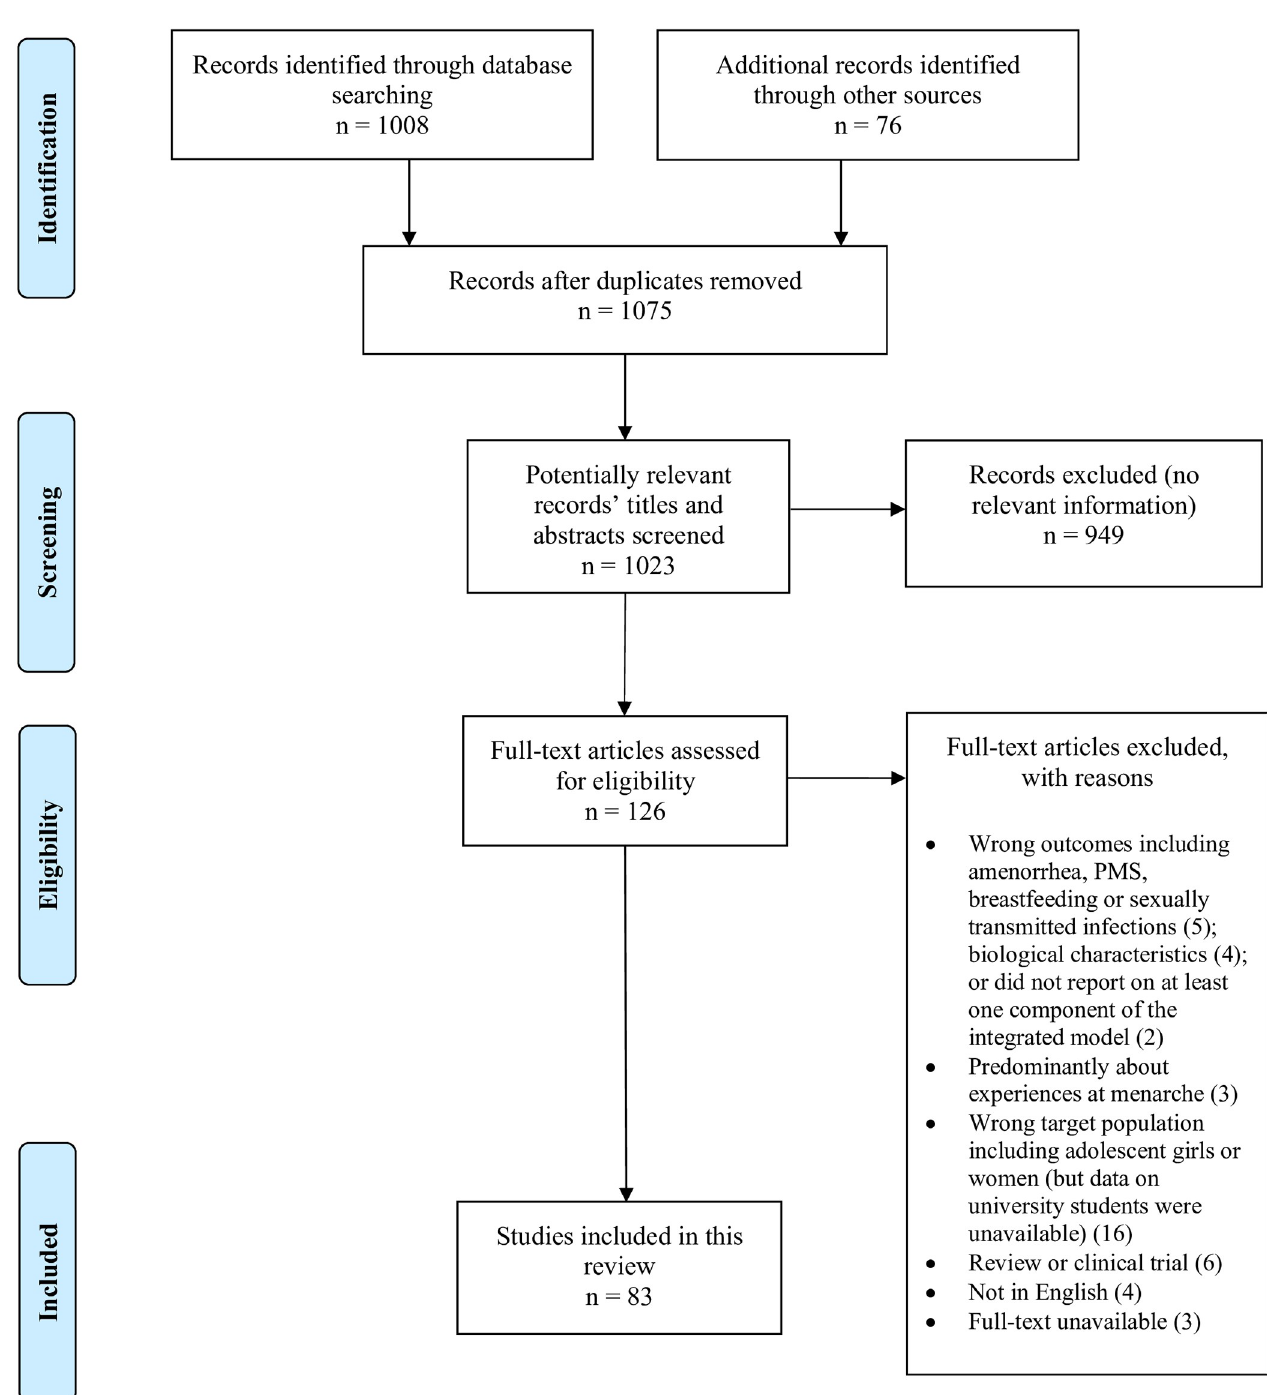
Fig 1. PRISMA flow diagram of the number of records identified, screened, assessed for eligibility and included in this review.